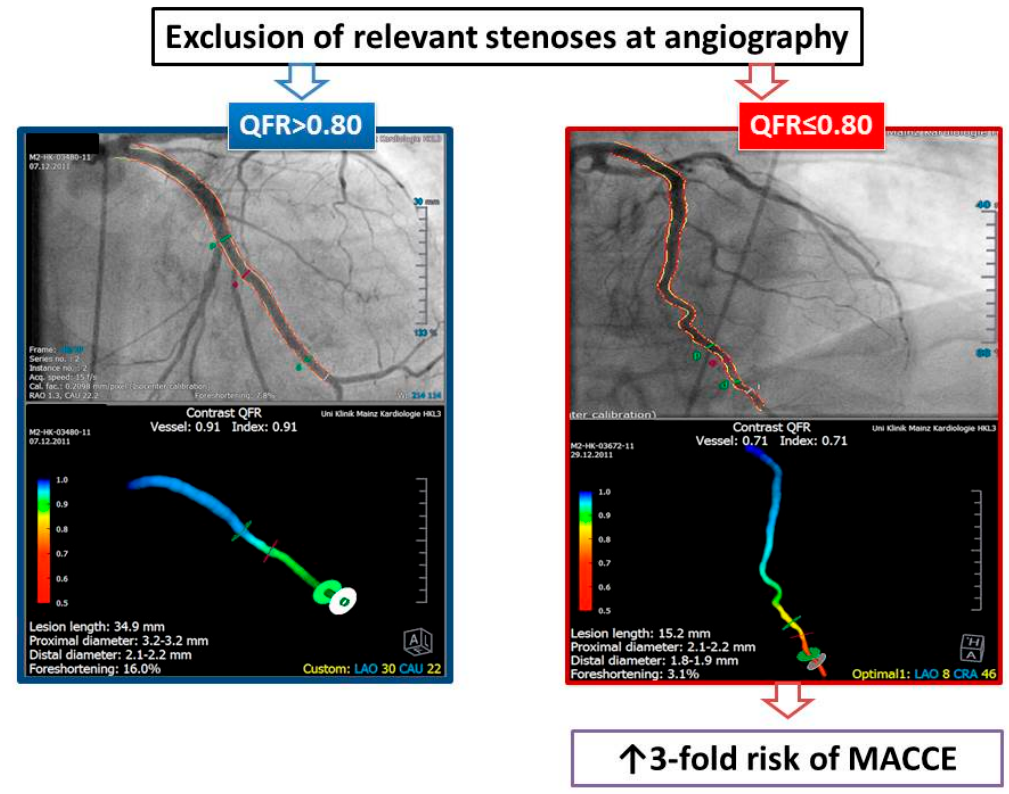
Figure 2. QFR analysis and take home message. Detection of QRF ≤ 0.80 in at least one coronary vessel is associated with a 3-fold higher risk to develop an adverse cardiovascular and cerebrovascular event during a long-term follow-up. MACCE: major adverse cardiovascular and cerebrovascular events.